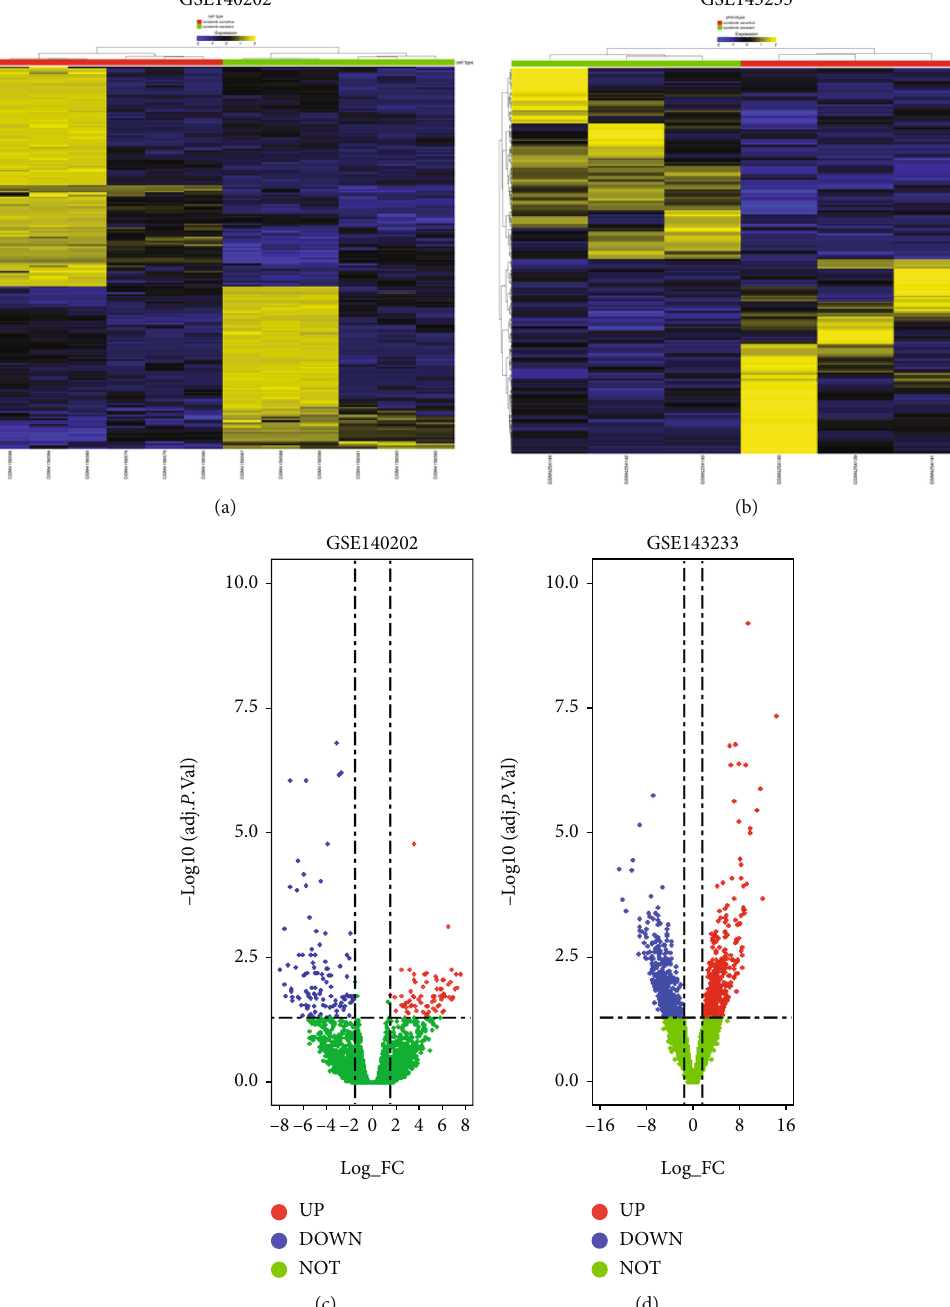
Figure 1: Heatmap and volcano plots of DEGs in GSE140202 and GSE143233. Heatmaps of the DEGs in (a) GSE140202 and (b) GSE143233 are shown. The volcano plots of DEGs in (a) GSE140202 and (b) GSE143233 are shown. UP: upregulated genes (red dots); DOWN: downregulated genes (blue dots); NOT: not signi fi cantly expressed genes (grey